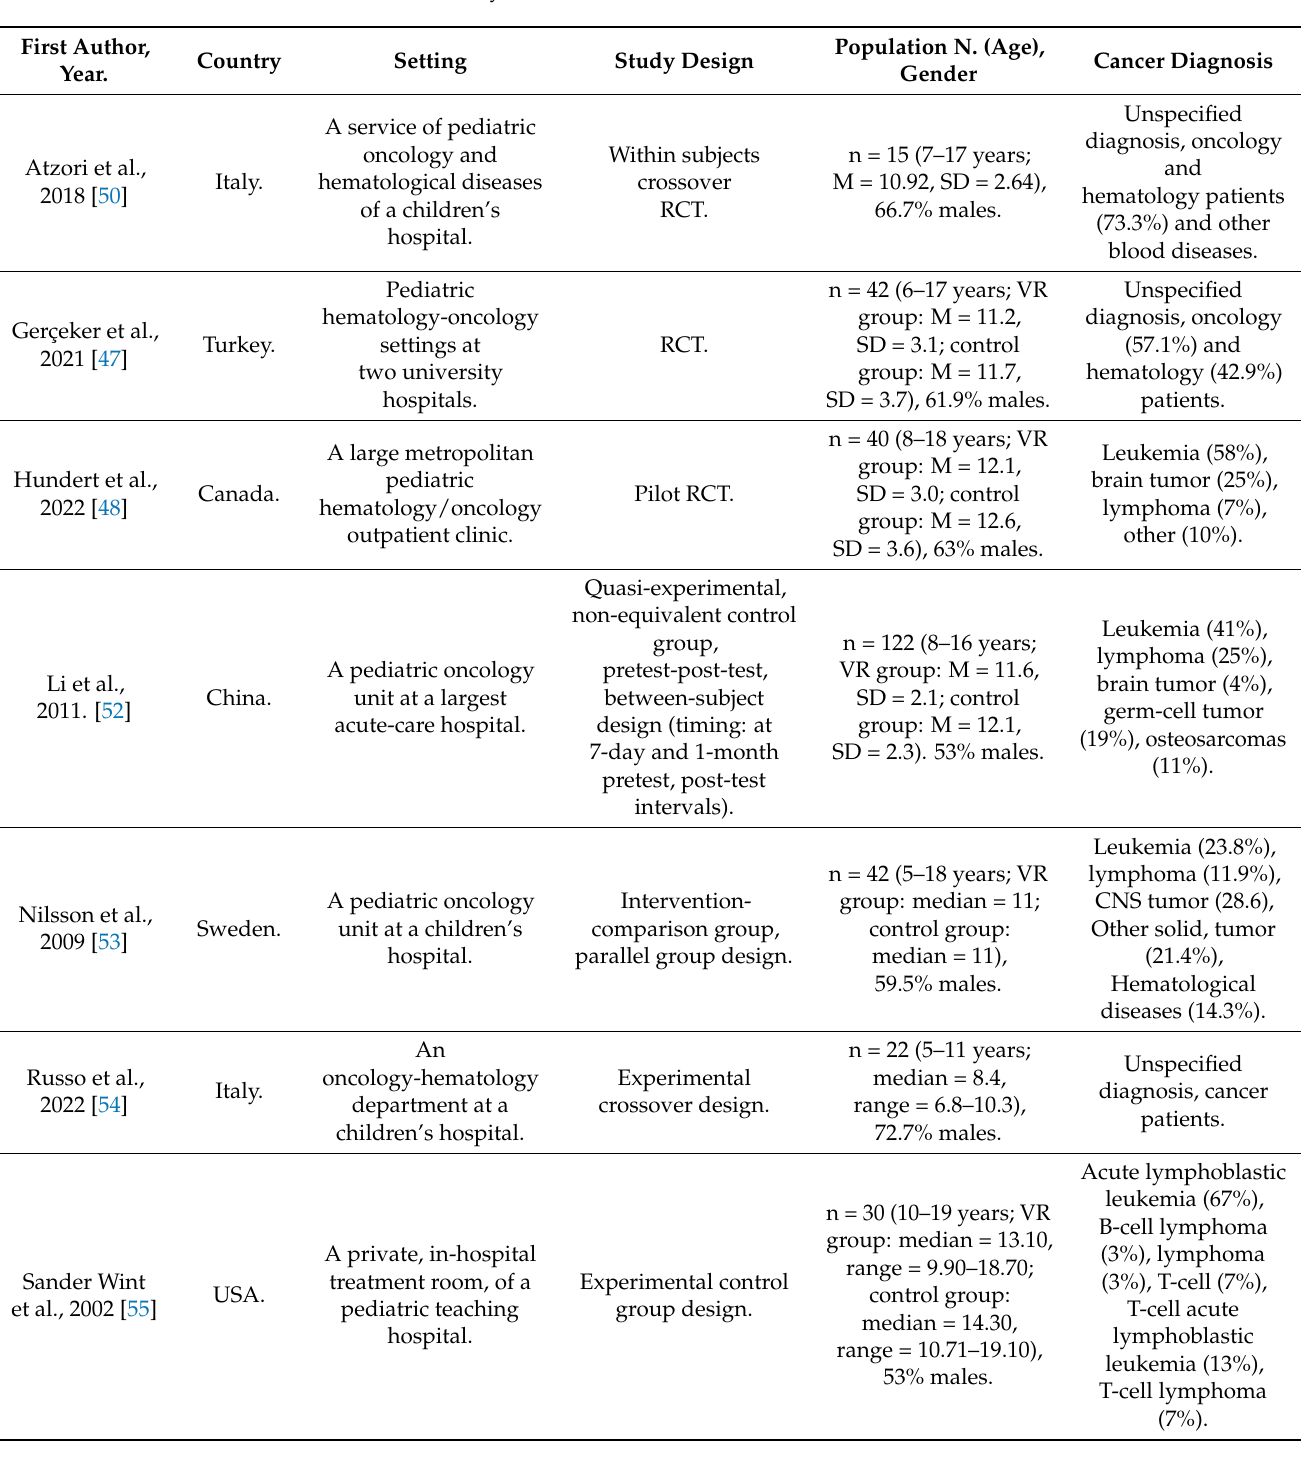
Table 4. Summary of the characteristics of included